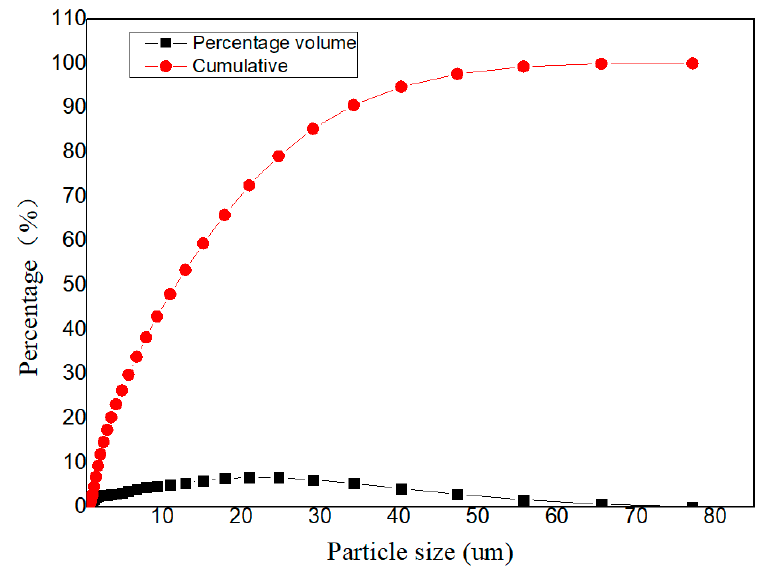
Figure 1. The particle size distribution of the tailings.